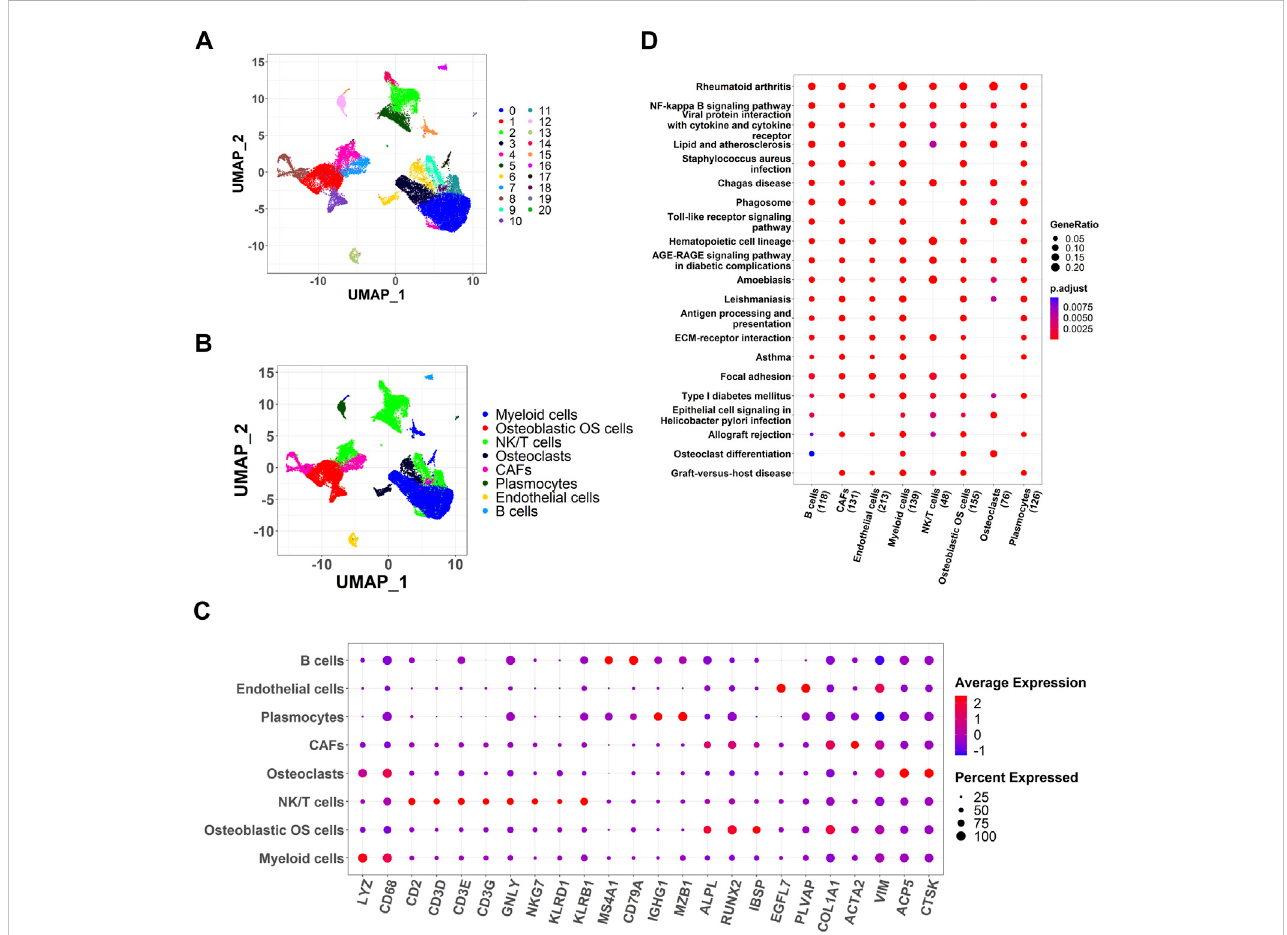
FIGURE 1 Identi fi cation of cell clusters and dimension reduction analysis. (A) Twenty-one cell clusters of dimension reduction analysis; (B) Ten cell types were identi fi edbymarkergenes; (C) Theexpressionofmarkergenesineightcelltypes; (D) KyotoEncyclopediaofGenesandGenomes(KEGG)enrichmentanalysis for marker genes of eight cell